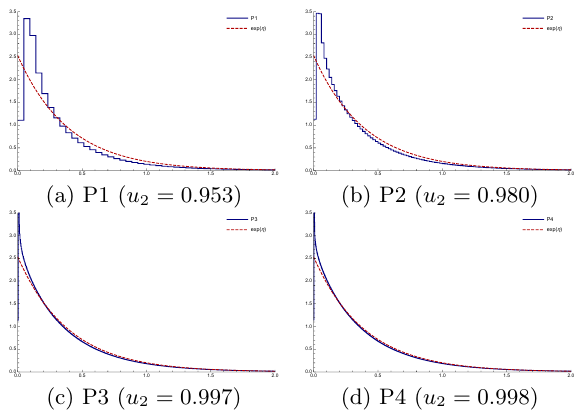
Figure 2: Simulated and theoretical scaled queue lengths for Example 3.